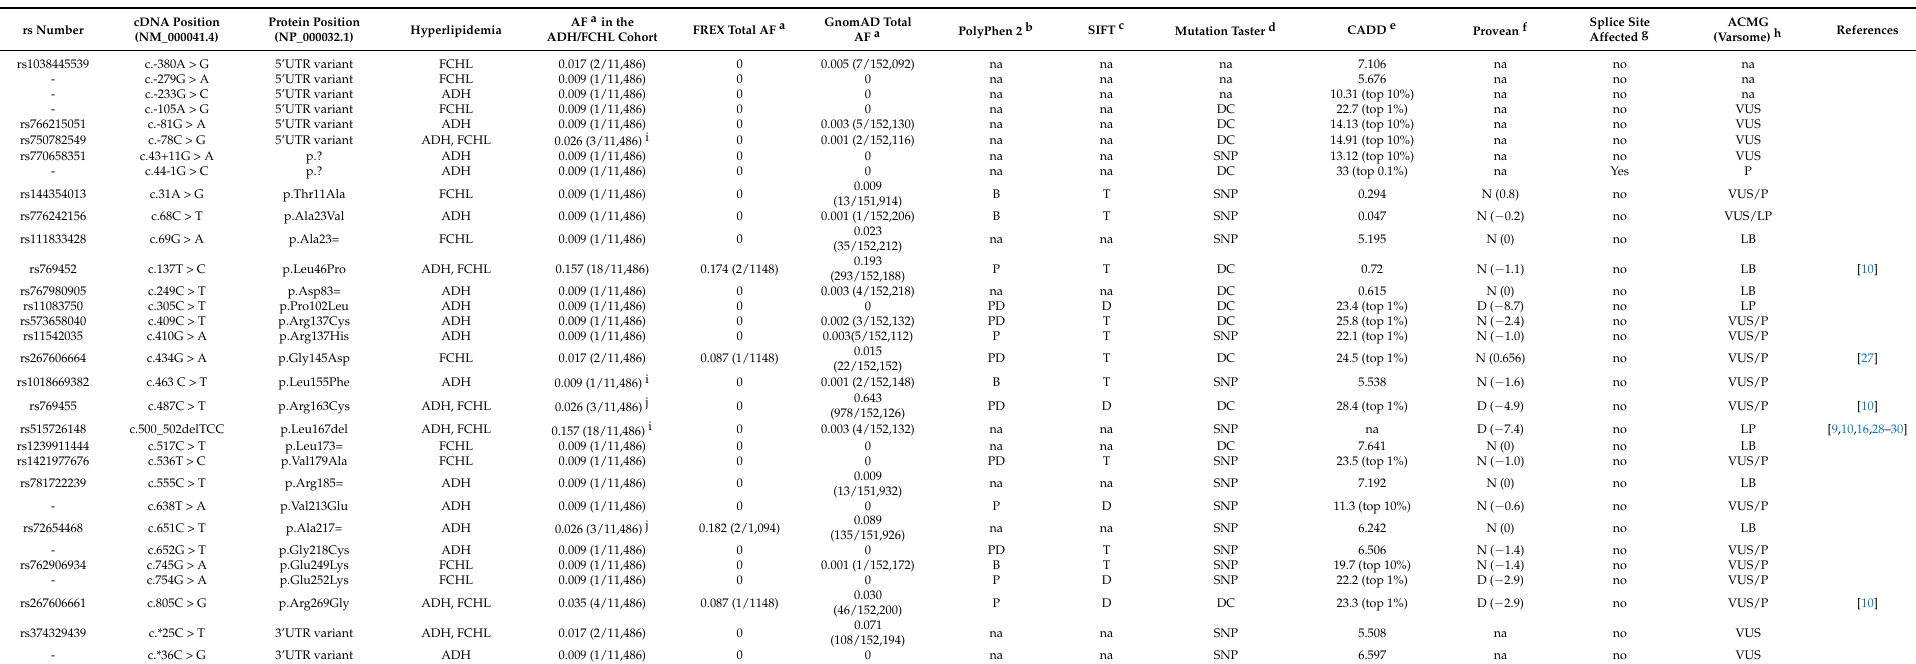
Table 2. Description of the 31 APOE